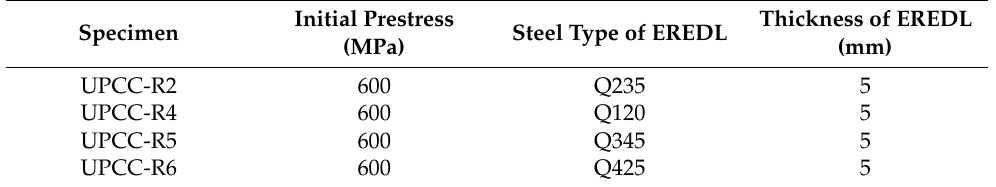
Table 9. Bridge pier working conditions under different steel yield strength of